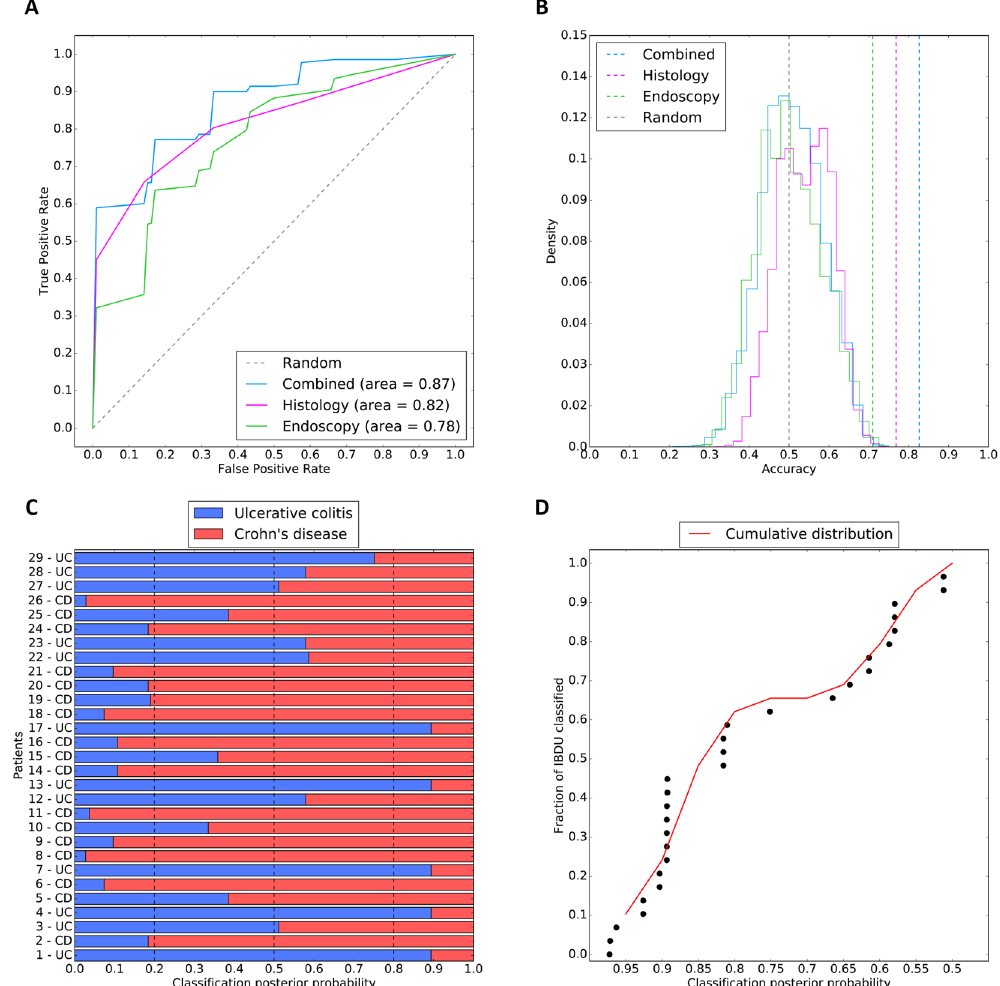
Figure 3. Supervised classification performance and metrics. ( A ) Receiver operating characteristic of the combined (light blue), histology (purple) and endoscopy (green) models. The grey dashed line represents the expected performance of a random model. ( B ) Permutation tests of models: dashed lines represent the observed accuracy of the combined (light blue), histology (purple) and endoscopy (green) models. The endoscopic, histological and combined models have a p-value of p = 3 × 10 − 3 , p = 5 × 10 − 6 and p = 1 × 10 − 6 respectively. The grey dashed line represents the average expected performance of random model. Solid coloured lines show the distribution of random permutations for each model. ( C ) Classification of IBDU patients with the combined model in Crohn’s disease (red) or ulcerative colitis (blue) subtypes. The classification posterior probability indicates the confidence of the model in assigning UC or CD labels. ( D ) Cumulative confidence in IBDU reclassification represented as cumulative density function (red line) of posterior probabilities for 29 IBDU patients. Each dot represents an IBDU patient.